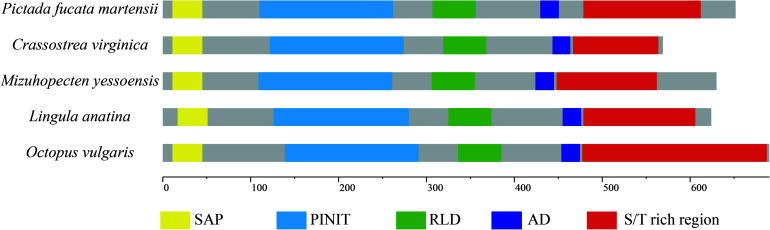
The structural organization analysis of PmPIAS. The frame of yellow, light blue, green, dark blue, and red represents SAP, PINIT, RLD domain, AD, and S/T-rich region, respectively. Accession numbers for sequences used in this alignment and structure analysis are as follows: Crassostrea virginica (XP_022331287.1), Mizuhopecten yessoensis (XP_021340266.1), Octopus vulgaris (XP_029634642.1), and Lingula anatina (XP_013385044.1).